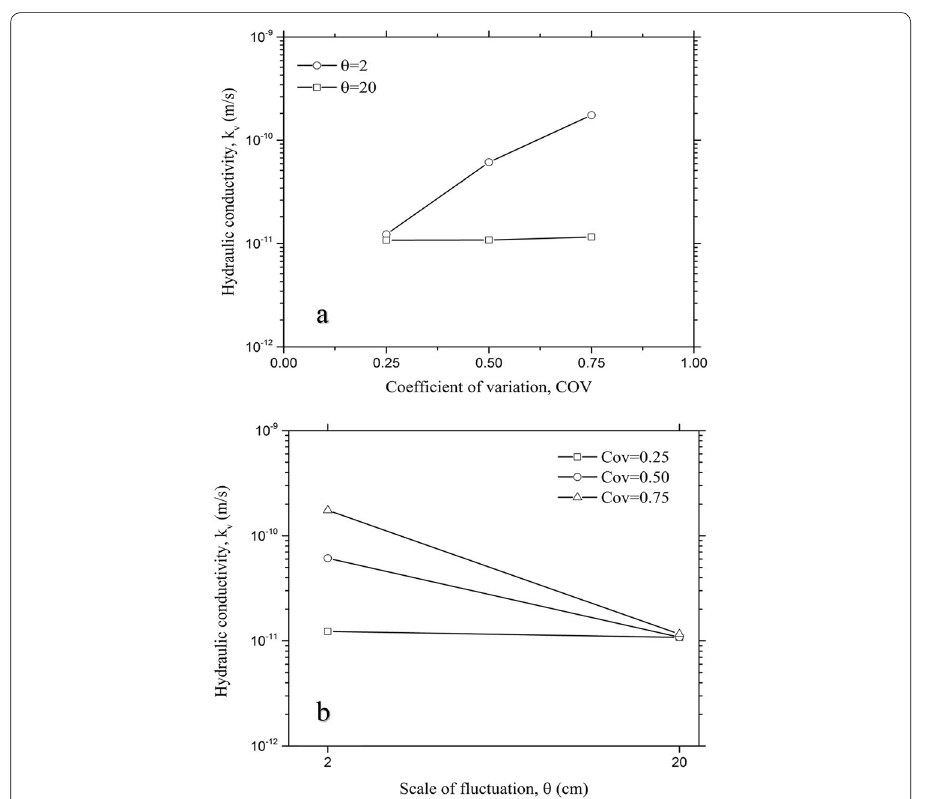
Fig. 12 Variation of the coefficient of permeability with: a coefficient of variation; and b scale of fluctuation for heterogeneous